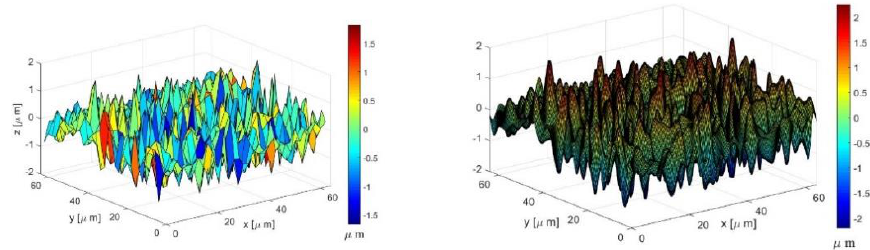
Figure 2. The original surface 63M and the surface after Fourier interpolation.